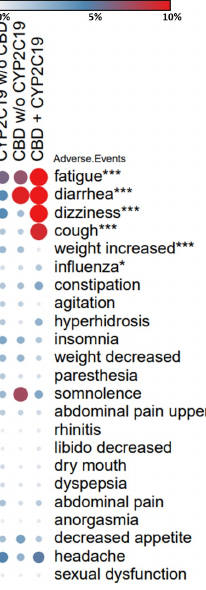
Figure 4. FAERS analysis of side effects in patients on antidepressants. The heatmap shows differential rates of side effects in patients on CYP2C19-metabolized medications (sertraline, es/citalopram), cannabinoids (CBD and THC) and the patients taking both as reported to FAERS. Rates of 23 side effects that are on the sertraline or es/citalopram label at >5% frequency were compared across three patient groups. Side effects with higher frequencies in the combination compared to the baseline (CYP2C19 medications without cannabinoids) and passing the FDR correction are highlighted using asterisks (* p < 0.05, *** p < 0.005). Frequencies of the side effects in the FAERS data are color coded as gray (0%), blue (5%), and red (10% or greater). Number of patients in each group: CYP2C19 (427,932), CBD (7008), CBD + CYP2C19 (421). Groups were mutually exclusive. Bejamini, Hochberg, and Yekutieli test used for FDR correction, significance threshold 0.05. FDR: false discovery